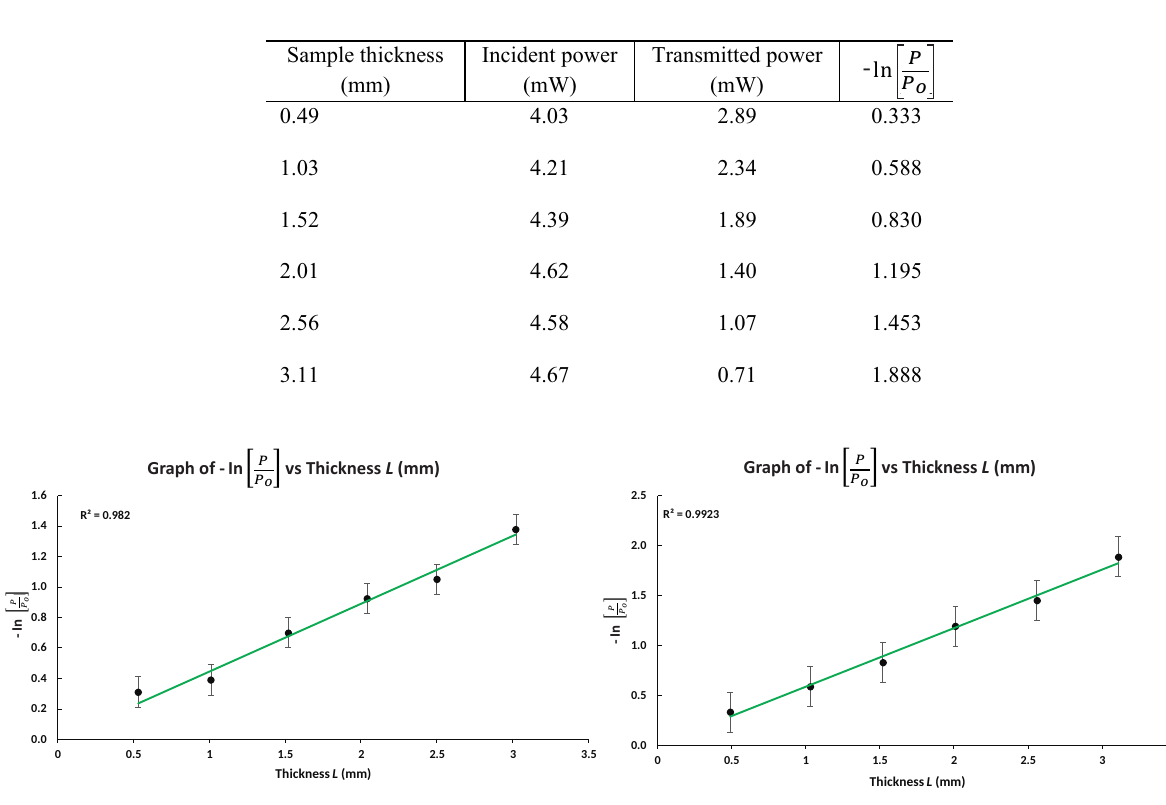
Fig. 2. Logarithmic intensity as a function of thickness with associated linear fit options to determine the total attenuation coefficient for the pure slime phantom at 630 nm.